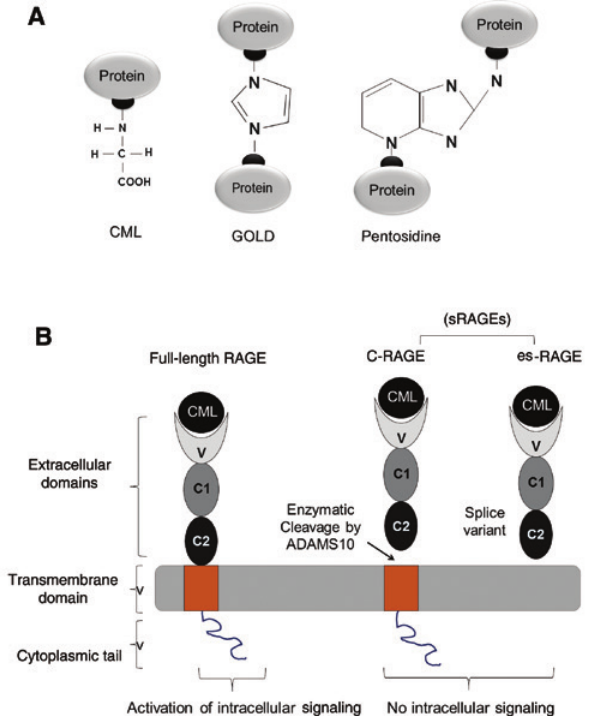
Figure 2: Schematic representation of predominant AGEs and receptors for AGEs (RAGE).